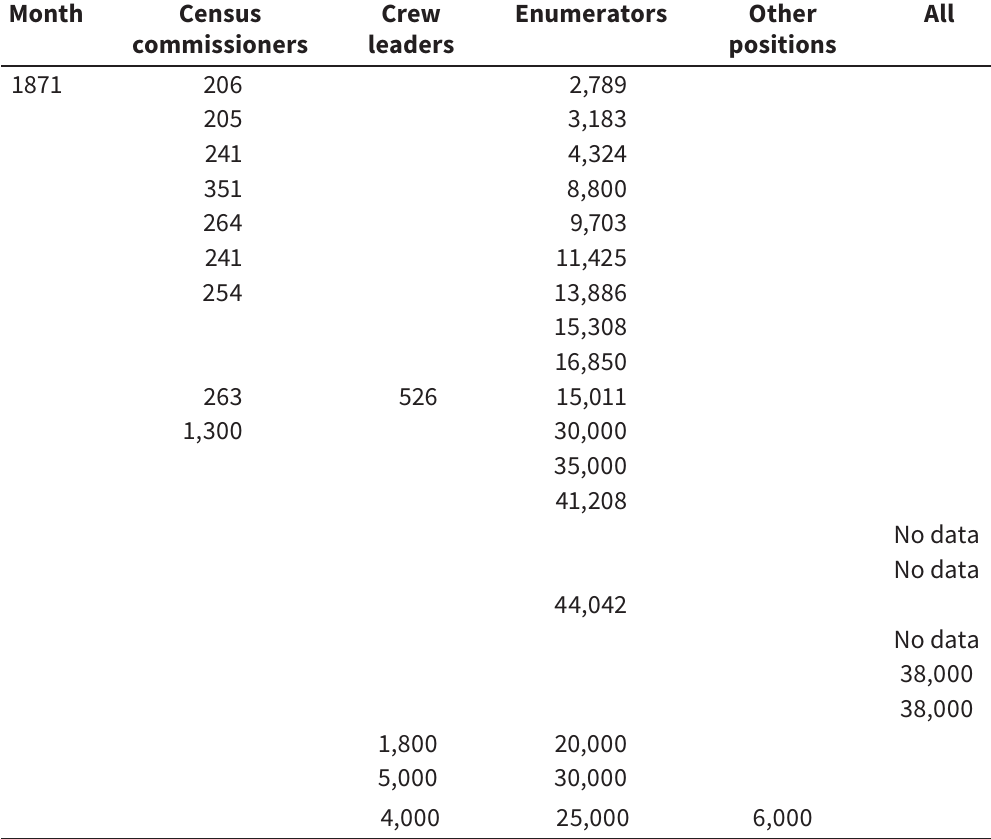
Historic census employment,